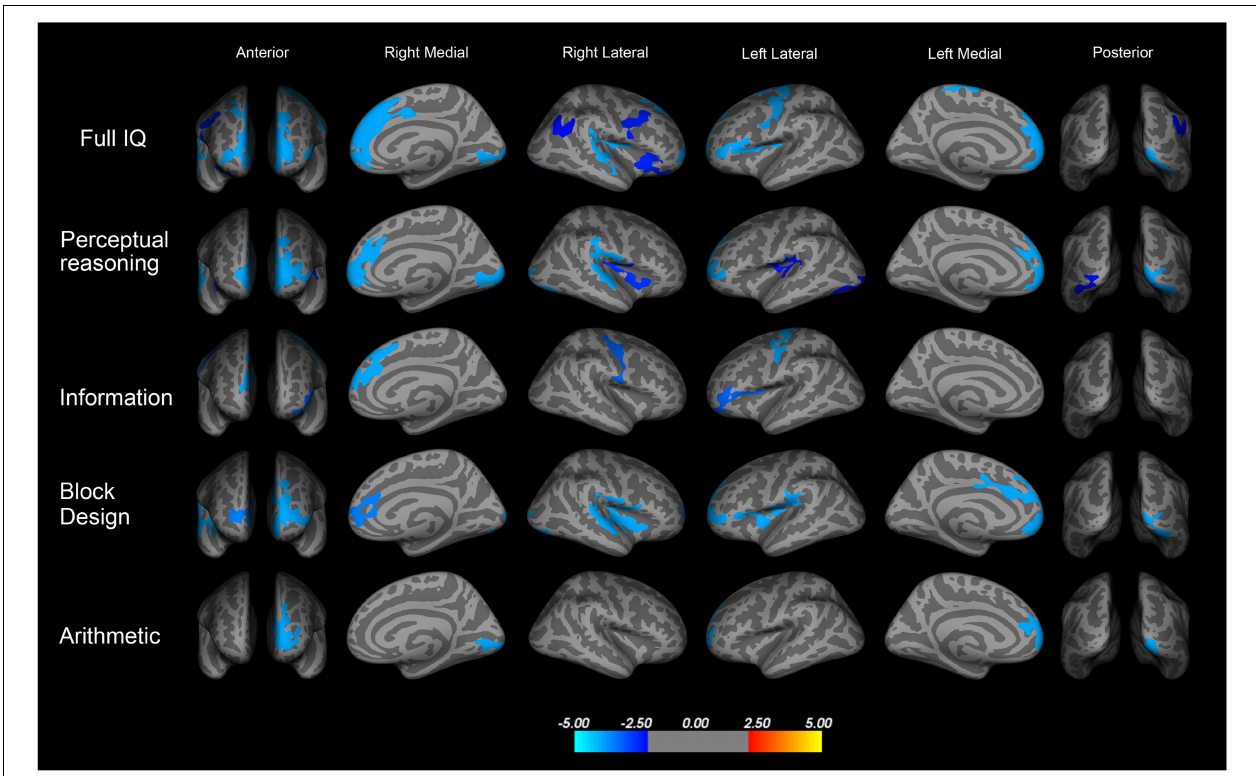
FIGURE 1 | Spatial negative correlation of cortical thickness and intelligence quotient (IQ) in children born very preterm and with VLBW at ages 8–16 ( p ≤ 0.05, corrected for ICV, age, and gender). Thickness of high order processing cortical areas (in blue) was associated with full scale IQ, specifically with perceptual reasoning index, and the subscales of information, block design, and arithmetic. Perceptual reasoning: frontal pole, mPFC (areas 24, 32, and 9), insula, posterior superior temporal gyrus, right inferior parietal cortex and extra striate visual cortex; Information: left inferior frontal and superior frontal gyrus, sensory and motor areas; Block design: left frontal pole and anterior cingulate cortex (area 24), superior medial frontal gyrus (areas 32 and 8/9), left inferior parietal cortex, and left extrastriate visual cortex, right posterior superior temporal gyrus, and insula; Arithmetic: left frontal pole and extrastriate visual cortex ( unpublished data